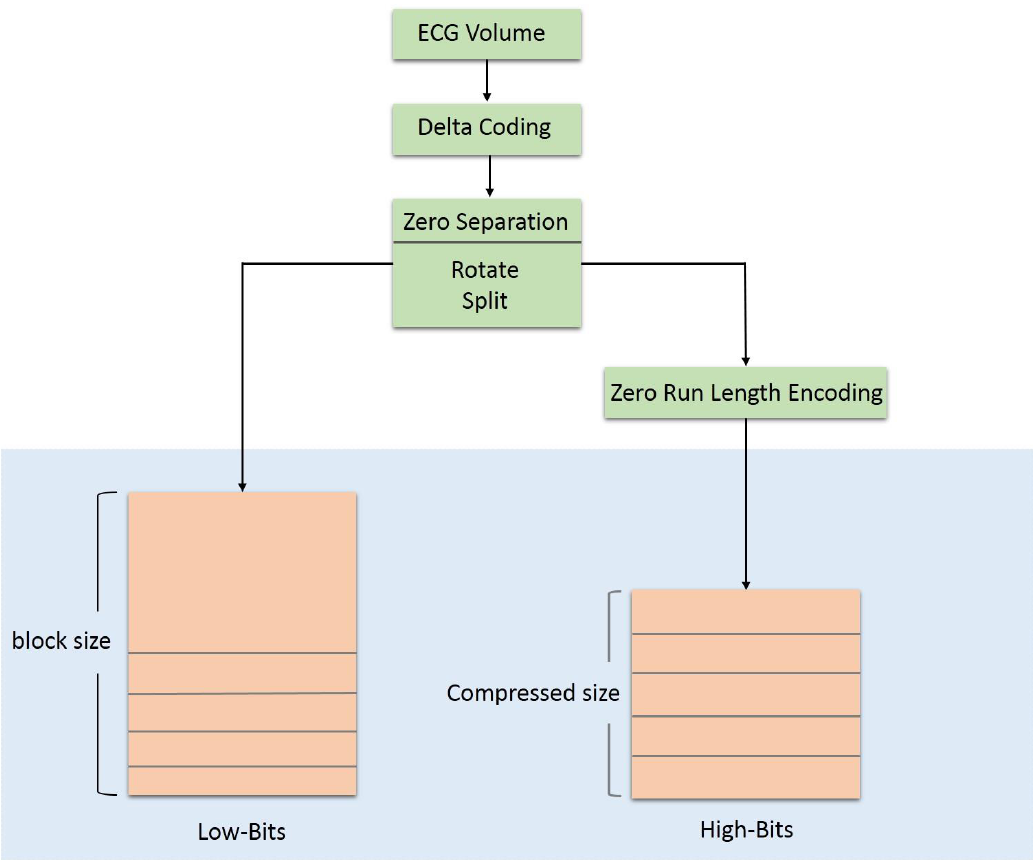
Figure 2. Flow chart.